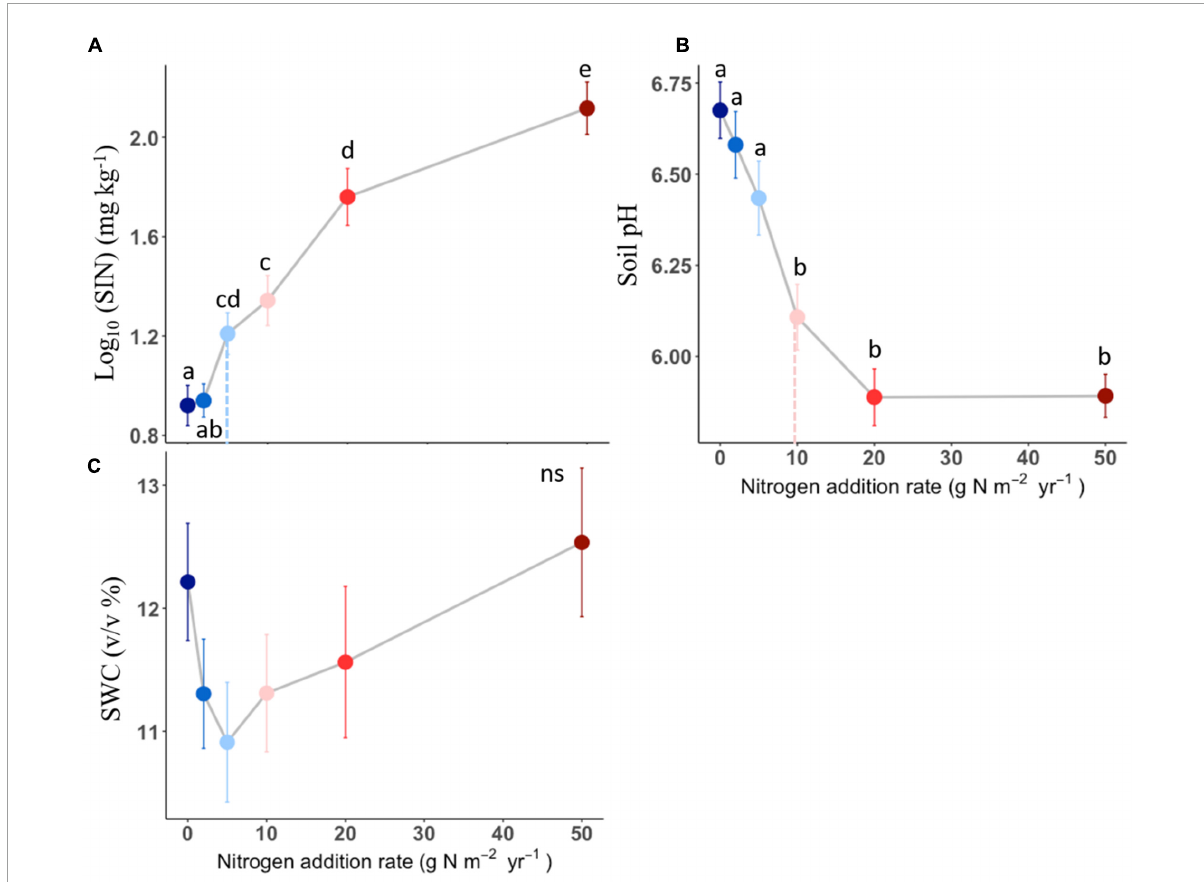
FIGURE3 Effects of different N addition on soil inorganic nitrogen (SIN, log 10 -transformed, A ), soil pH (B) , soil water content (SWC, C ). Different lower-case letters indicate significant differences ( P < 0.05) between treatments, and ns indicates non-significant ( P > 0.05). The dashed line in each panel indicate for tipping points. The data shown are the means with 40 replications ± standard